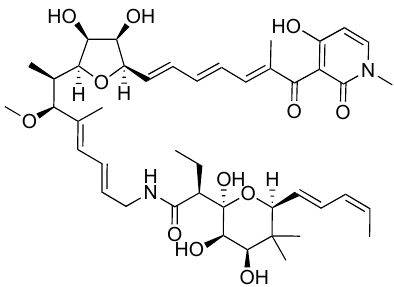
Figure 4. Structure of aurodox, a polyketide isolated from Streptomyces sp. K06-0806.